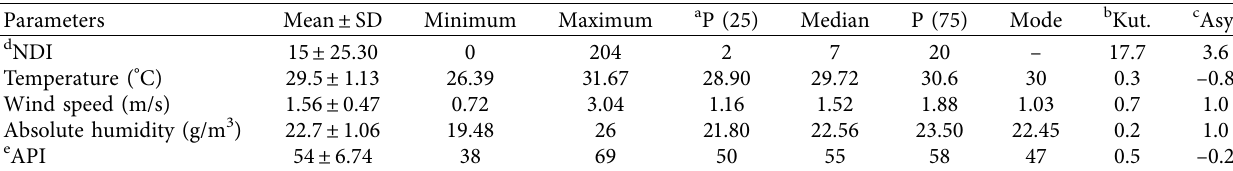
Table 1: Descriptive statistics of COVID-19 cases and weather variables in Kuala Lumpur from 14 March 2020 to 31 August 2020.